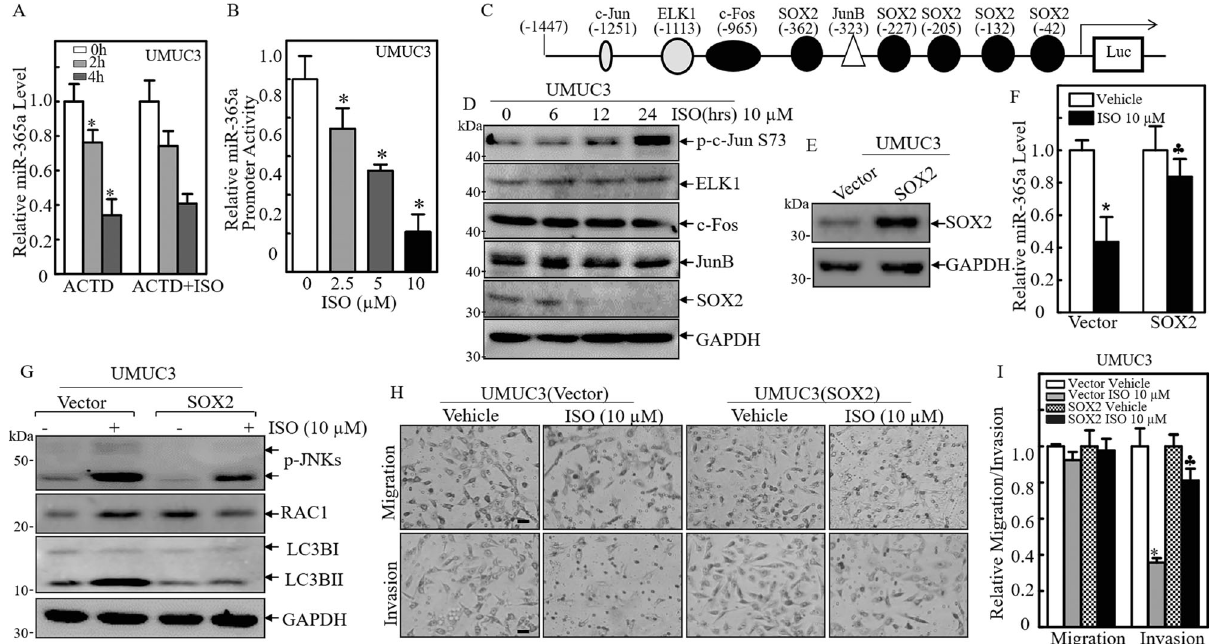
Fig. 4 ISO treatment attenuated SOX2 expression and, in turn, reduced miR-365a transcription and expression. A UMUC3 cells were co- incubated with ISO (10 μ M) and Act D (20 μ g/ml) for indicated time periods. Total RNA was isolated and quantitative real-time PCR was then performed to determine miR-365a levels. GAPDH was used as an internal control. Results were presented as the Mean±SD of triplicates. * Signi fi cant decrease from vehicle control ( p < 0.05). B UMUC3 stably transfected with miR-365a promoter-driven luciferase reporter was treated with ISO at different concentrations for 24 h to determine the potential effect of ISO on miR-365a promoter transcriptional activity. C Schematic representation of the putative transcription factor consensus binding sites in the miR-365a proximal promoter region D The protein expressions of potential transcription factors was determined by Western blot in UMUC3 cells treated with ISO (10 μ M) for indicated time periods. E Over-expression of SOX2 constructs were stably transfected into UMUC3 cells and the stable transfectants were identi fi ed by Western blot. F Over-expression of SOX2 reversed the inhibition effect of ISO on miR-365a relative expression in UMUC3 cells. G Over- expression of SOX2 reversed ISO-induced RAC1, p-JNK and LC3B-II protein abundance in UMUC3 cells. H , I UMUC3(SOX2) and UMUC3(Vector) were used for determination of their migration and invasion abilities in the presence of either vehicle or 10 μ M of ISO treatment for 24 h. Results were presented as the mean ± SD of triplicates. * Signi fi cant difference between vector control and overexpression group ( p < 0.05). ♣ Signi fi cant increase from UMUC3(Vector) treated with ISO alone ( p <